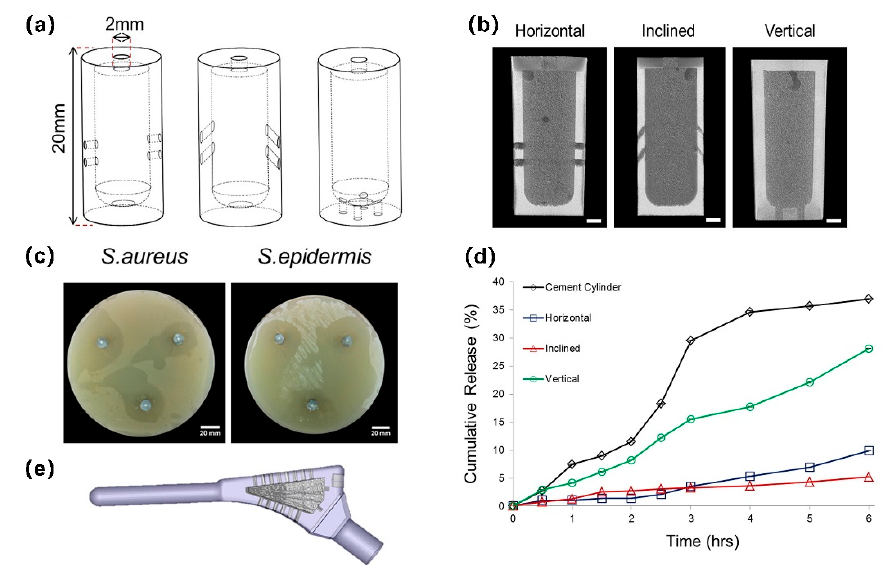
Figure 4. SLM Ti6Al4V implants containing a reservoir. Adapted with permission from ref. [85]. Copyright 2016 Elsevier. ( a ) Schematics of implants with horizontal, inclined, and vertical pore channels; ( b ) coronal slice of antibiotic-loaded ce- ment within implants; ( c ) zones of bacterial inhibition around implants with horizontally orientated pore channels show- ing directionality; ( d ) cumulative release of antibiotic from cement cylinders and cement-filled implants with different pore orientations; ( e ) re-engineered functional implant. The filling material plays a pivotal role in the release spectrum, and its material type and solubility affect the reaction; for example, drugs with a higher water solubility exhibit a faster drug release rate [84]. The second factor is the state of the material that is filled. If the drug is directly filled, the elution involves one stage, and the drug is directly released from the channel. If the medium contains antibiotics, such as mesoporous silica particles or bone cement, the elution involves two stages: The drug is first desorbed from the me- dium and then released through the implant channels [85,89]. This two-stage eluting de- vice has the ability to precisely control the drug release rate, because the drug medium and the hollow implant channel can be controlled independently. The drug loading and drug eluting of these hollow Ti implants had promising anti- bacterial effects [85,88,90], which indicates that an optimized drug release profile could be achieved by rational structural design; however, a complete design scheme has not been proposed to date. 3.2. Porous Implants 3.2.1. Bioactive Coating As a result of the increased surface area of porous implants, there is great potential for loading antimicrobial agents through coatings and surface treatments. Burton et al. [91] studied eight unit cell types of AM porous lattices and determined that the original Schwartz lattice geometry with 10% volume filling maintains the loading capacity, while allowing the maximum void volume in all lattice designs to load more antimicrobial agents. In addition to a homogeneous porous lattice structure, AM technology can also be used to manufacture implants with gradient porosity or surface blind pores. Sukhorukova et al. [92] used SLS to prepare a square blind holes network structure for loading antibi- otics onto the surface of Ti plates. This had an obvious antibacterial effect, which was su- perior to the standard plate that contained a higher concentration of antibiotics. Active coatings release preincorporated antimicrobial agents, such as antibiotics [93], inorganic antimicrobials [94,95] (e.g., silver (Ag), zinc (Zn), copper (Cu), gallium (Ga)),